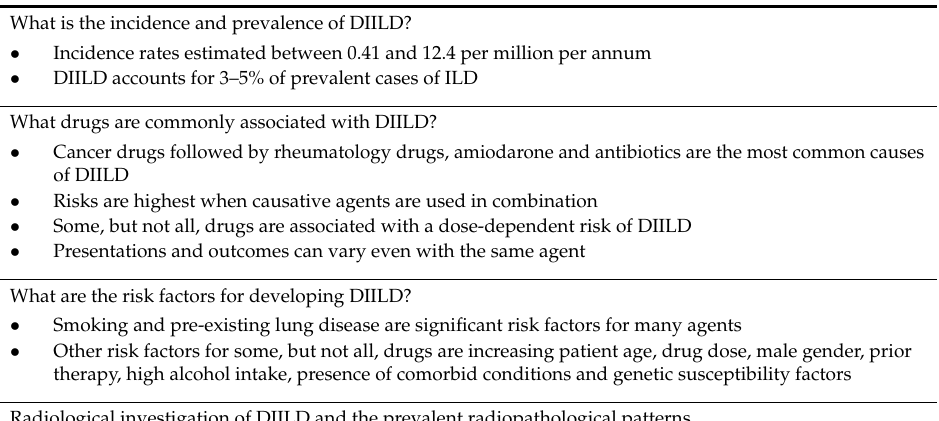
Table 4. Key findings for each